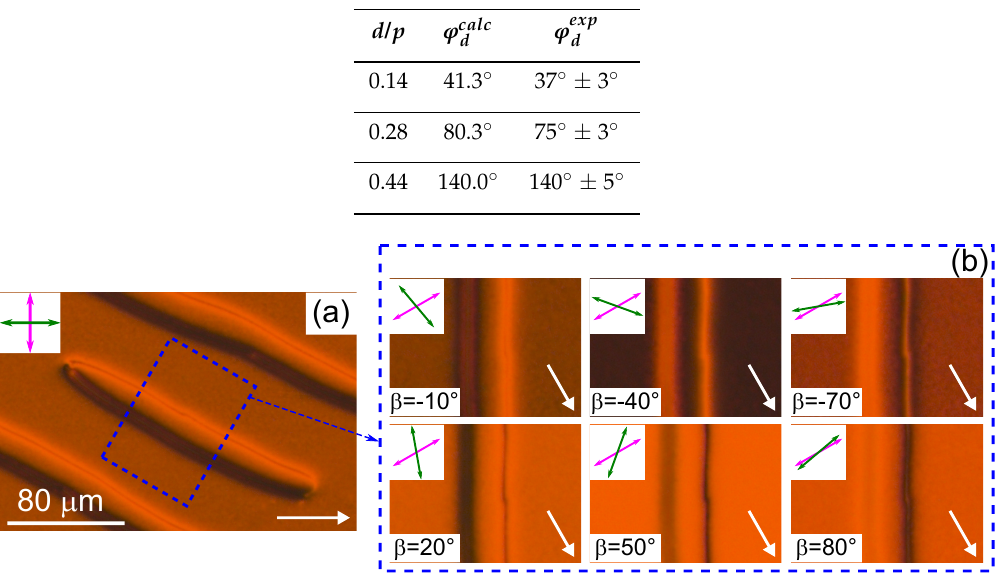
Table 1. The theoretically calculated ( ϕ calc angle of director rotation at the substrate covered with PiBMA in the LC cells with d / p = 0.14, 0.28, 0.44.